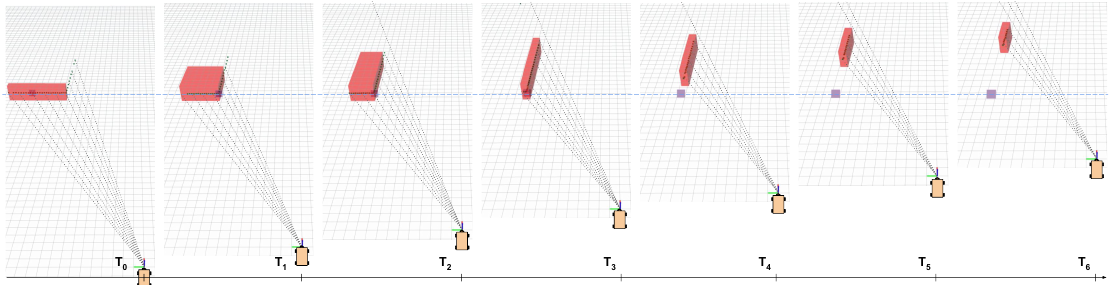
Figure 6. Size update and reference propagation of an object over associated detections with partial visibility. In T 0 , we observe the object with no reliable features, so that its centroid is tagged as reference point. From T 1 to T 3 , the object is visualized from a different perspective, and the reference is updated to the visible corner. In times T 4 , T 5 , T 6 , the object is partially observed but, as it is matched during the fast-matching step, the old corner is propagated, and the reference point updated. Best viewed in